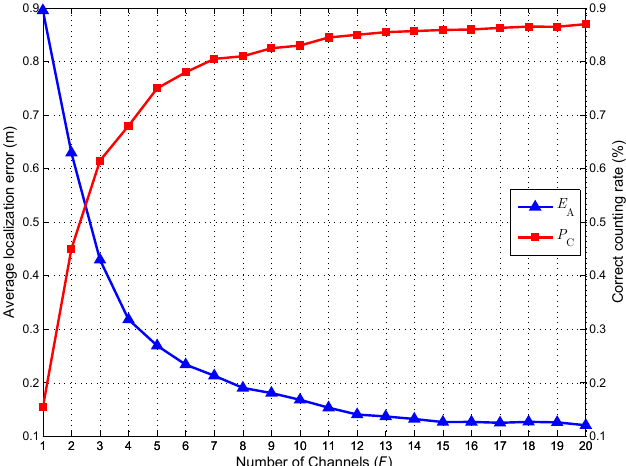
Figure 5. Counting and localization performance when the number of channels varies from 1 to